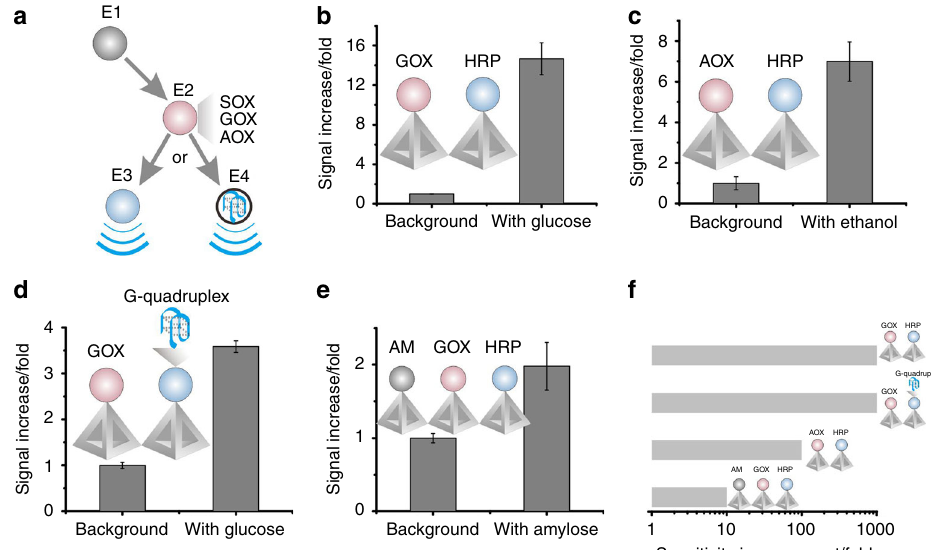
Fig. 3 Generality of the BEH strategy for multi-enzyme-cascade on electrodes. a Design principle for bienzyme-cascade (E2/E3 or E2/E4) or trienzyme- cascade (E1/E2/E3) reactions. b Bienzyme-cascade for glucose detection using glucose oxidase (GOX) and HRP. c Bienzyme-cascade for ethanol detection using alcohol oxidase (AOX) and HRP. d Bienzyme-cascade for glucose detection using GOX and a DNAzyme (G-quadruplex-based peroxidase mimic). e Trienzyme-cascade for amylose detection using amyloglucosidase (AM), GOX and HRP cascade based BEH for the detection of amylose. f The sensors using BEH-engineered electrodes demonstrate sensitivity improvement by 1 – 3 orders of magnitude as compared to BEH-free ones. Error bars represent the mean ± s.d. of triplicates. Source data are provided as a Source Data fi